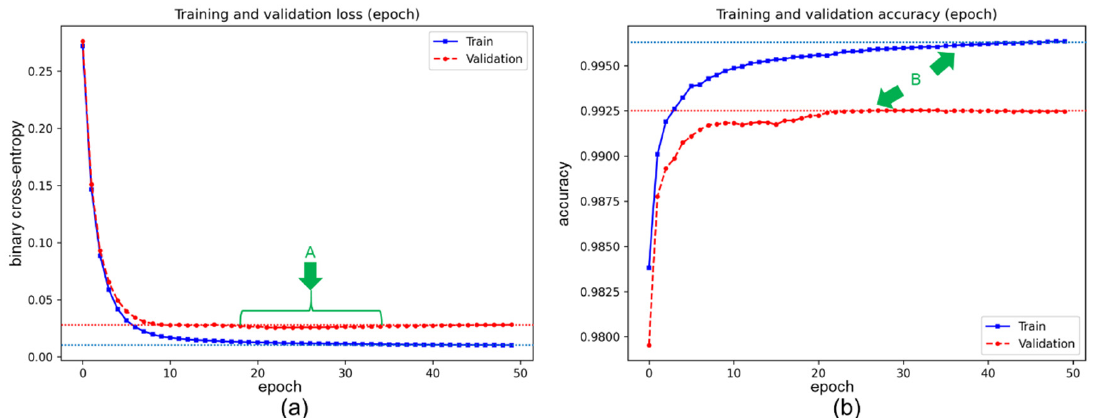
Figure A6. The loss and accuracy curves of NI-U-Net [57] using the synthetic dataset. The green “A” and “B” correspond to the two highlights mentioned in Section 3.2. ( a ) Refers to the epoch-wised loss curves in the training and validation sets. ( b ) Refers to the epoch-wised accuracy curves in the training and validation sets. The horizontal dash lines refer to the references of final converge status.